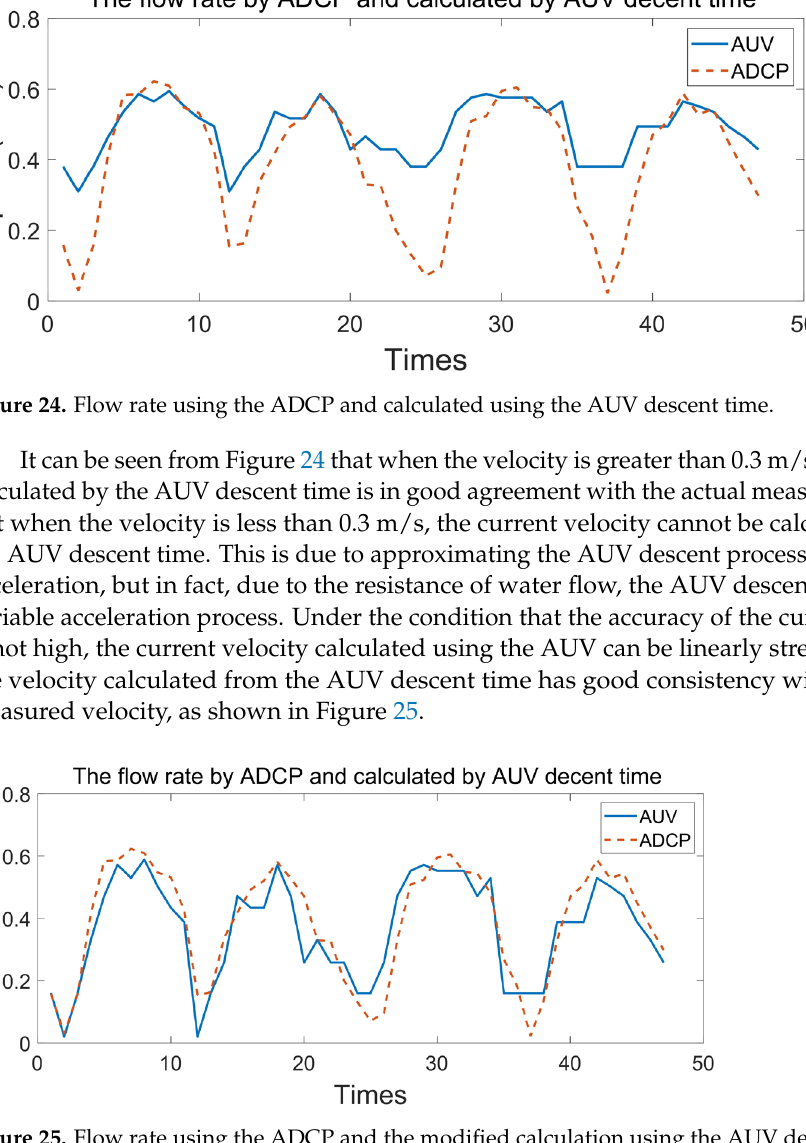
Figure 25. Flow rate using the ADCP and the modified calculation using the AUV descent time .